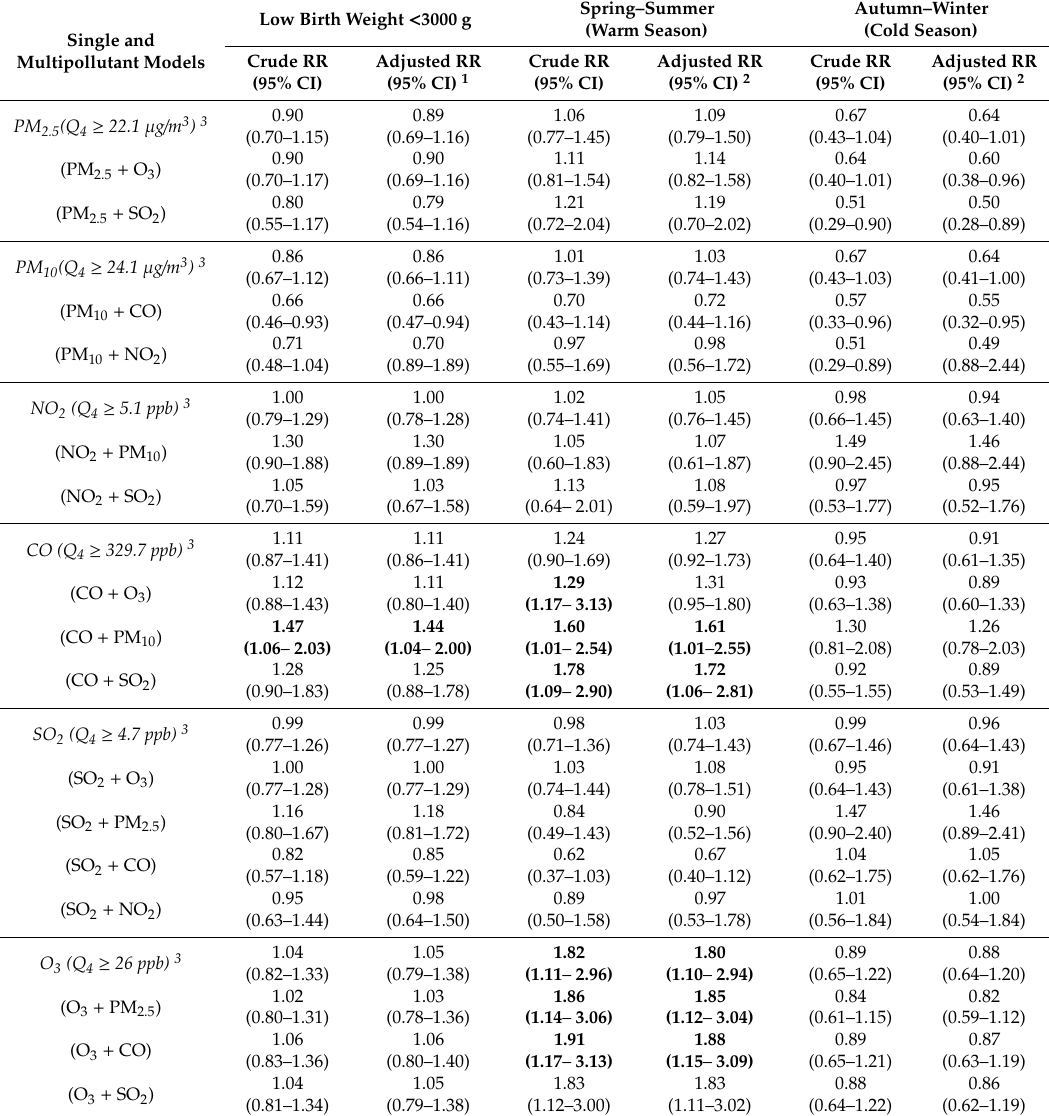
Table 4. The e ff ects of air pollution exposure during entire pregnancy on low birth weight less than 3000 g (N = 2517), The Espoo Cohort Study,